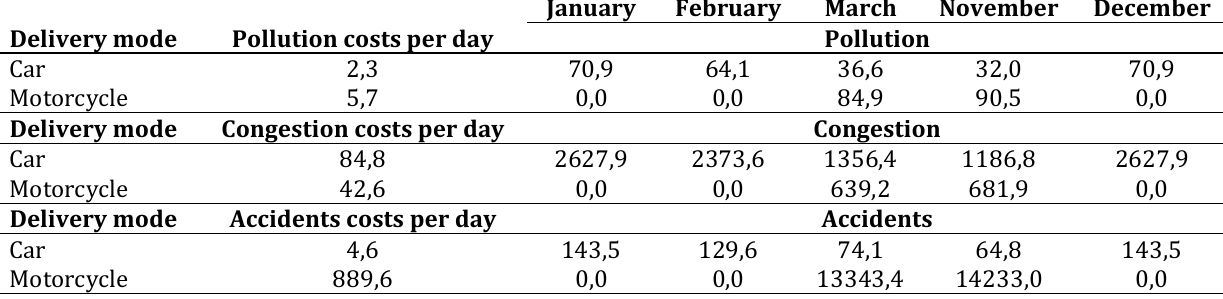
Table 11: External costs of combination “Car+Bicycle” for season with difficult weather conditions Delivery mode